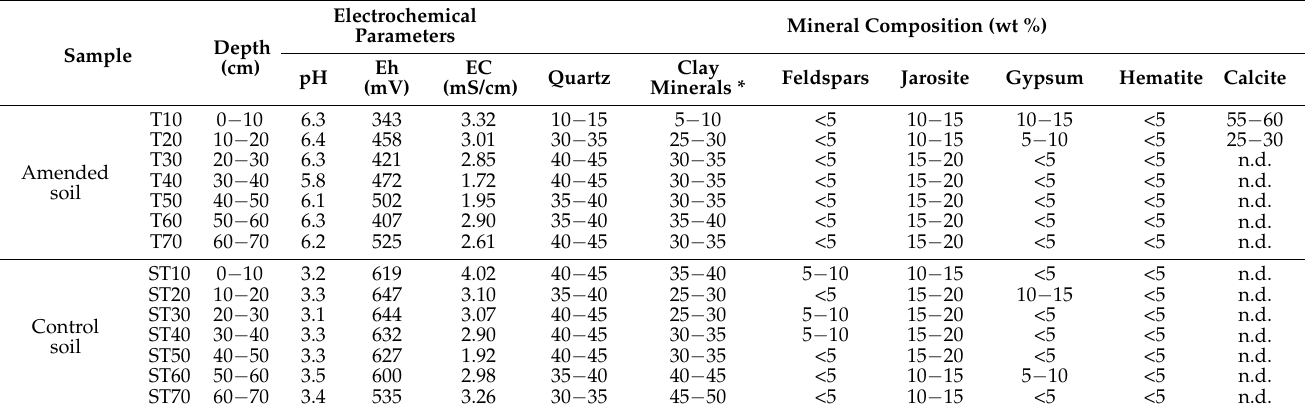
Table 1. Electrochemical properties and semiquantitative mineral composition of the samples.